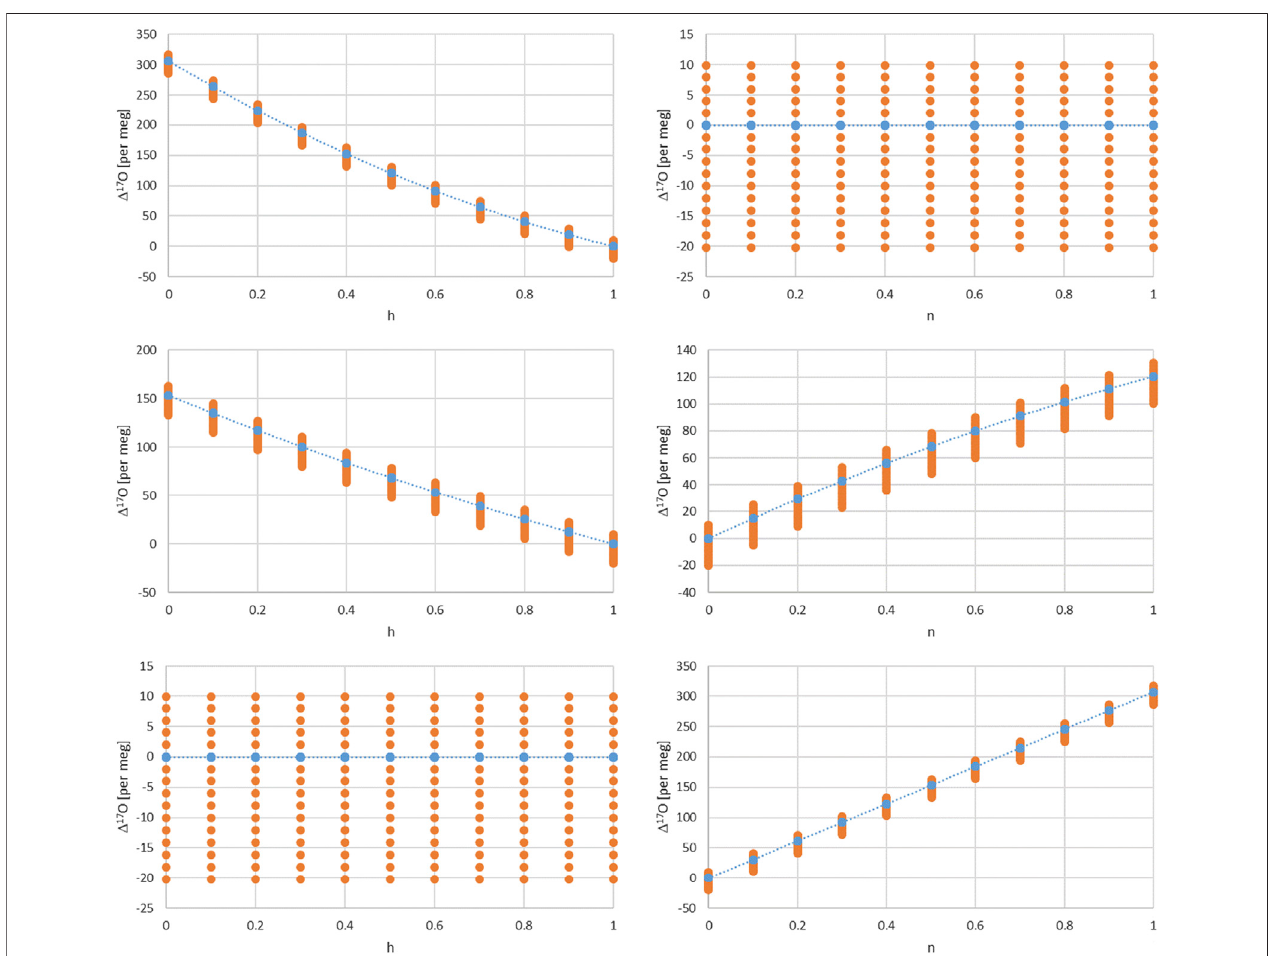
FIGURE 3 | Dependence of Δ 17 O on the relative humidity h for different turbulence factors of 1, 0.5, and 0 (upper, middle and lower left panels). Dependence of Δ 17 Oontheturbulencefactor n fordifferentrelativehumidityvaluesof1,0.5and0(upper,middleandlowerrightpanels).Thedotscorrespondsto δ 18Ovaluesfrom − 20 to 10 per mil in steps of 2 and therefore indirectly to a temperature range shown in Figure 4